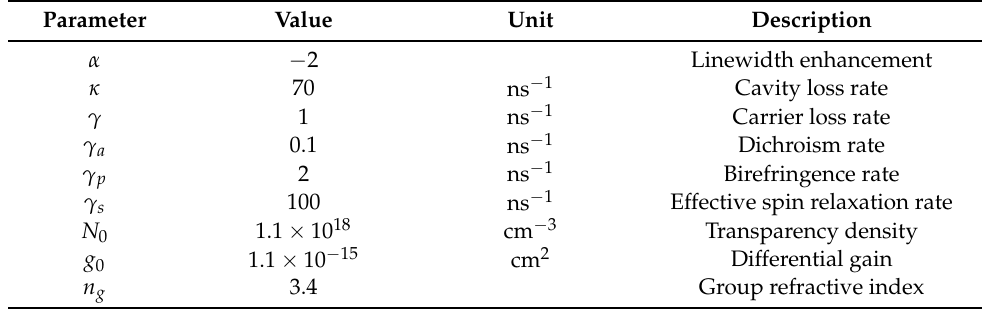
Table 3. Laser parameters used in numerical simulations. Note that we tabulate the effective